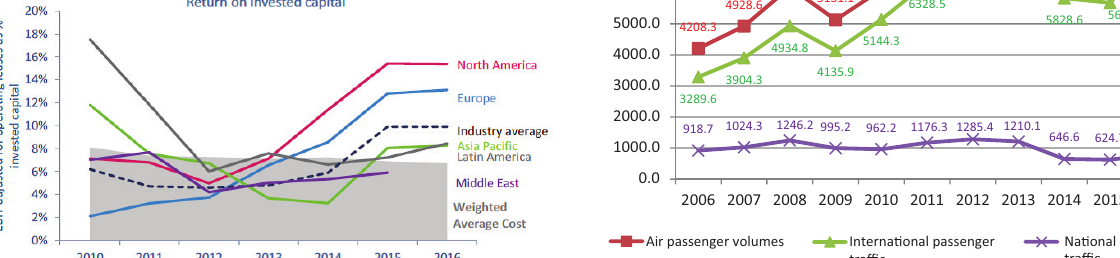
Figure 4. Volumes of passenger transportation by